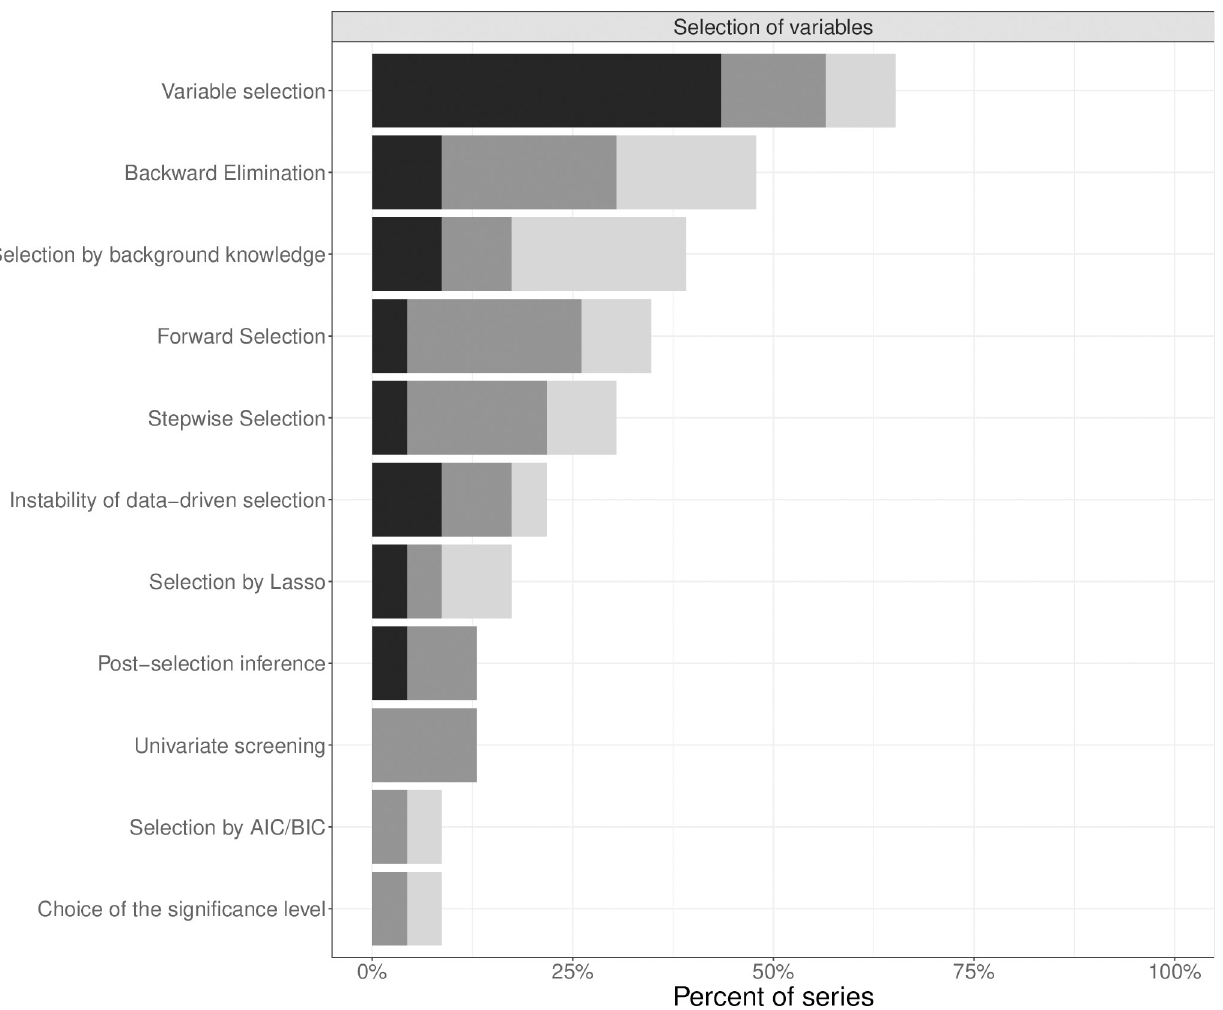
Fig 5. Extent of explanation of aspects of selection of variables in statistical series: One sentence only (light grey), more than one sentence to one paragraph (grey) and more than one paragraph (black).